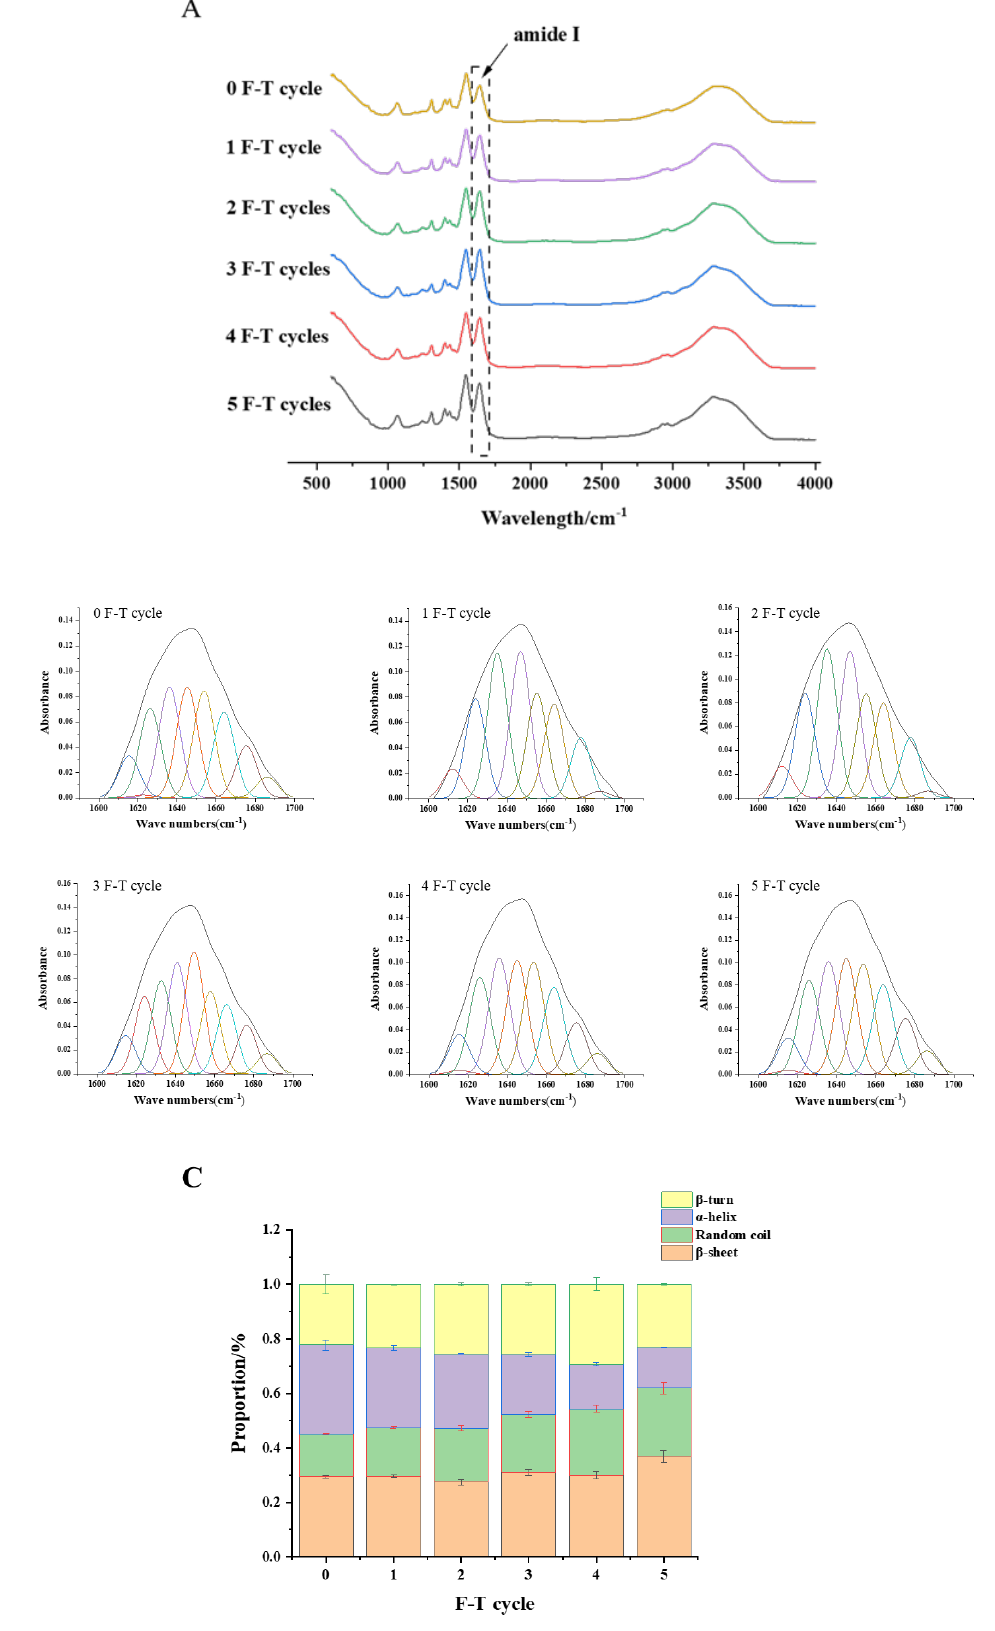
Figure 6. FTIR spectra ( A ), iterative curve-fitted ( B ), secondary structure content ( C ) of cuttlefish after F-T cycles. Error bars show standard deviation. The letters “a–e” indicate significant differences ( p < 0.05).